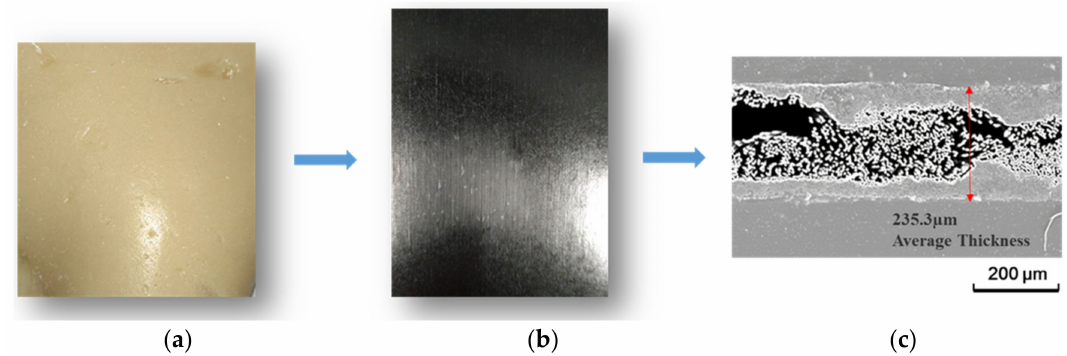
Figure 1. ( a ) The developed out-of-autoclave resin; ( b ) unidirectional prepreg manufactured with developed out-of-autoclave resin; ( c ) optical micrographs for the